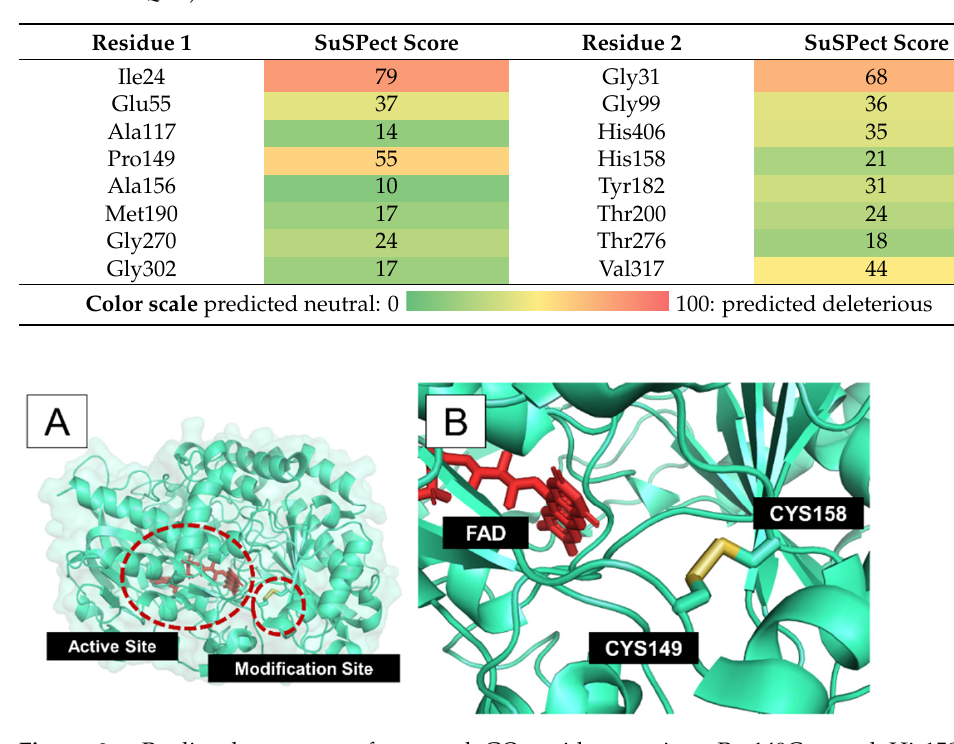
1: most conserved